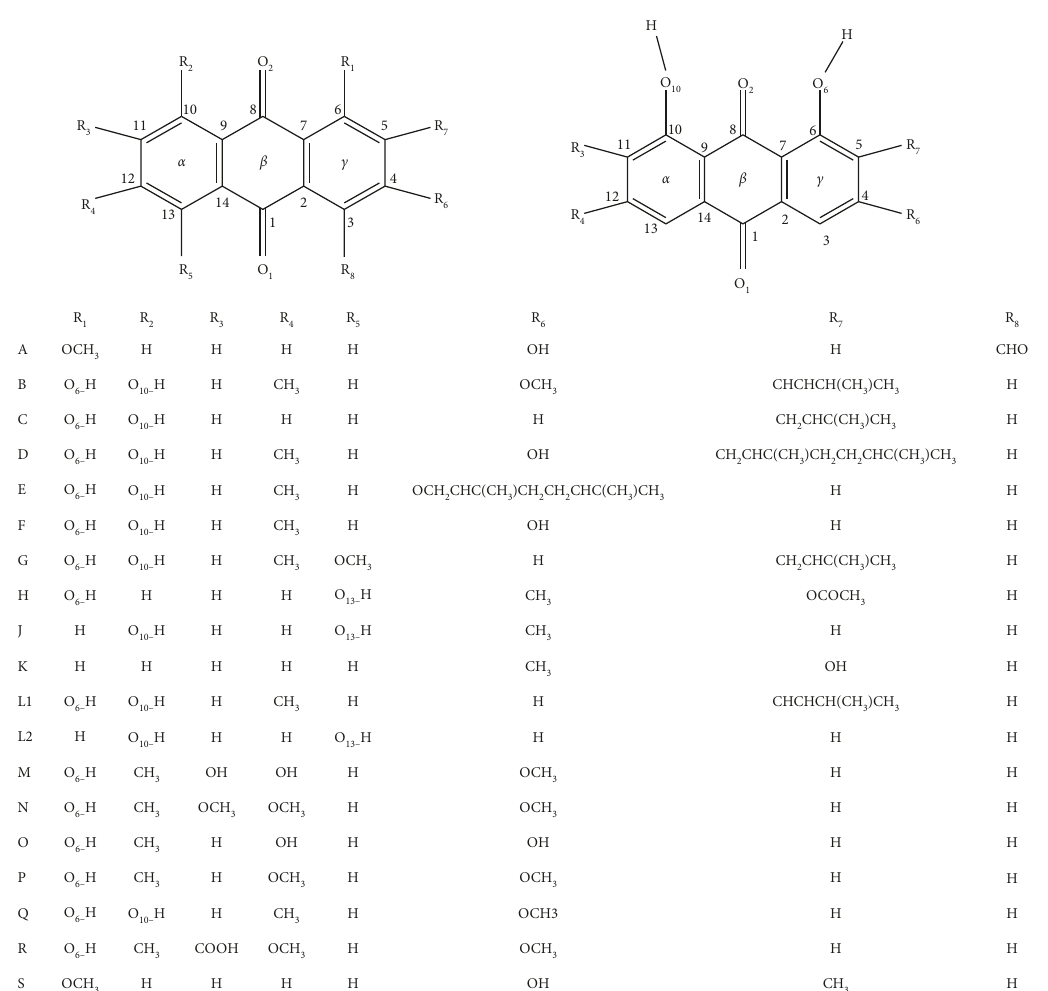
Figure 2: Numbering system used to designate atom of the anthraquinone system of the molecular library